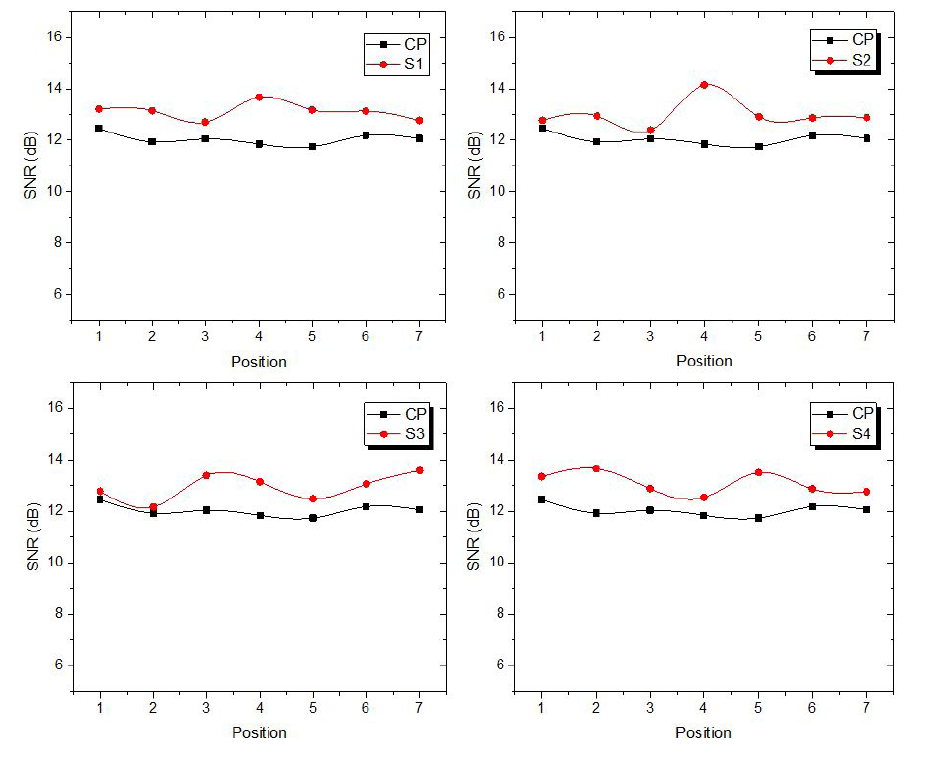
Figure 10. Results of the SNR for samples with fiber waviness.